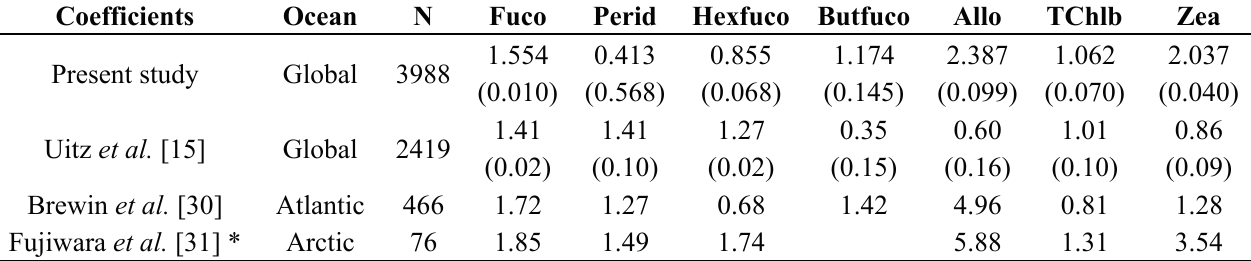
Table 3. The partial regression coefficients and standard deviation (in brackets) where available. The number of samples is indicated by N. The empty fields indicate that the coefficient is not statistically